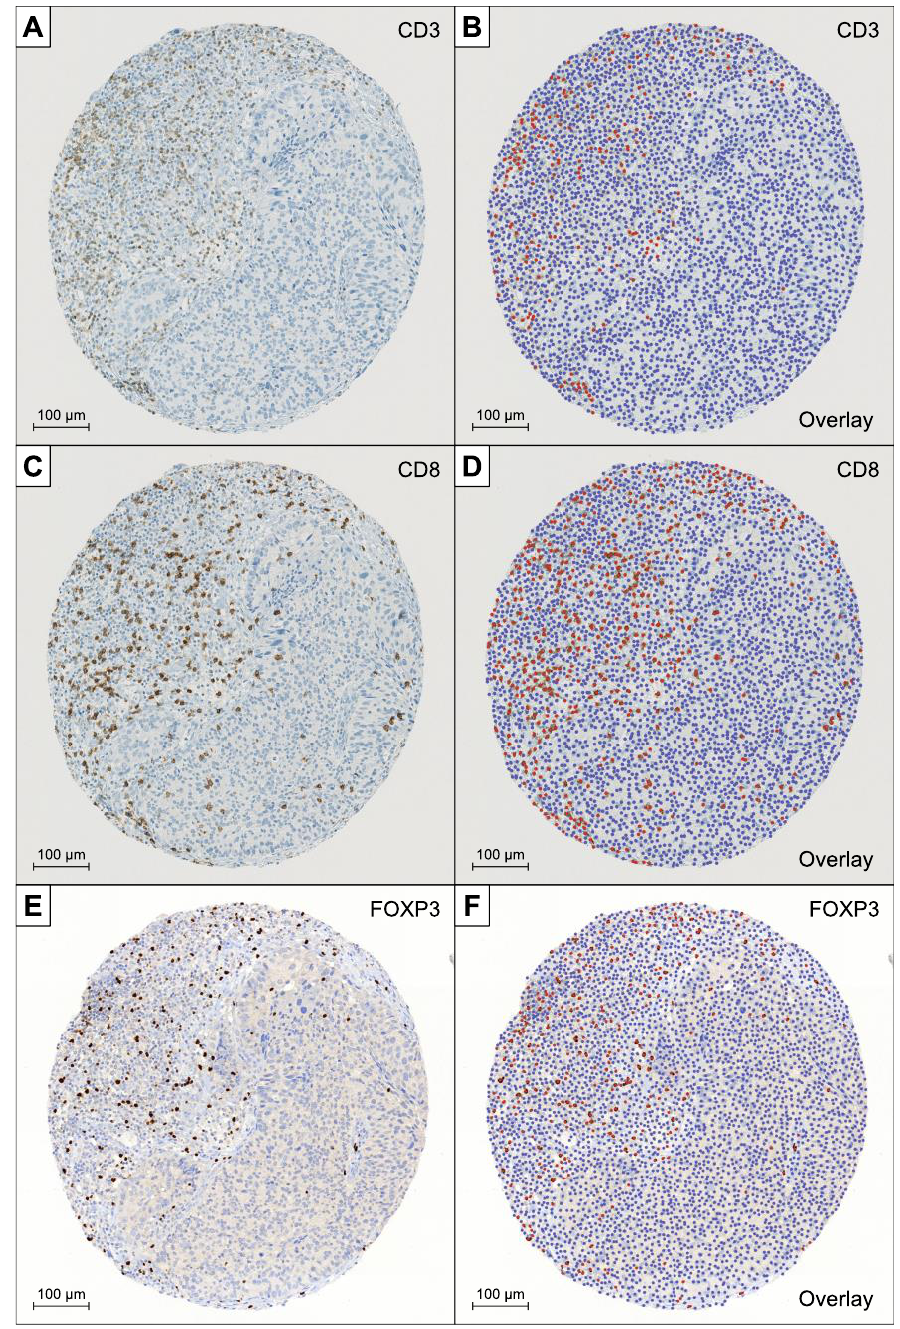
Figure 1. Overview of exemplary samples of scanned TMA-sections stained with antibodies for CD3 ( A ), CD8 ( C ), and FOXP3 ( E ) and the corresponding overlays generated by QuPath ( B , D , F ). Red dots highlight the lymphocytes that where rated positive, while the blue dots are showing the remaining detected cells that were counted as negative.